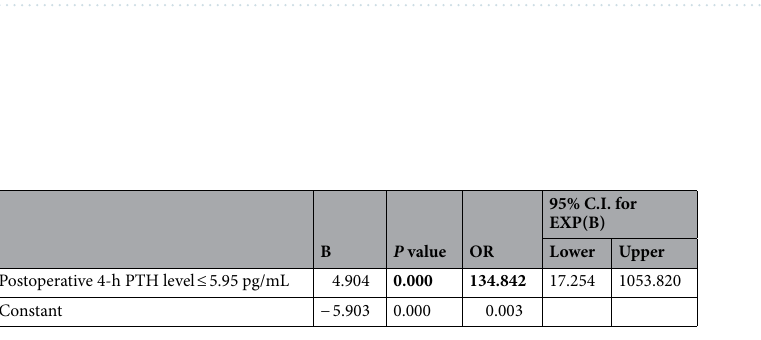
Table 5. Comparison of postoperative normalization time of PTH levels with and without parathyroid autotransplantation. n Number, Mann–Whitney U test used. Min . minimum, Max. maximum.